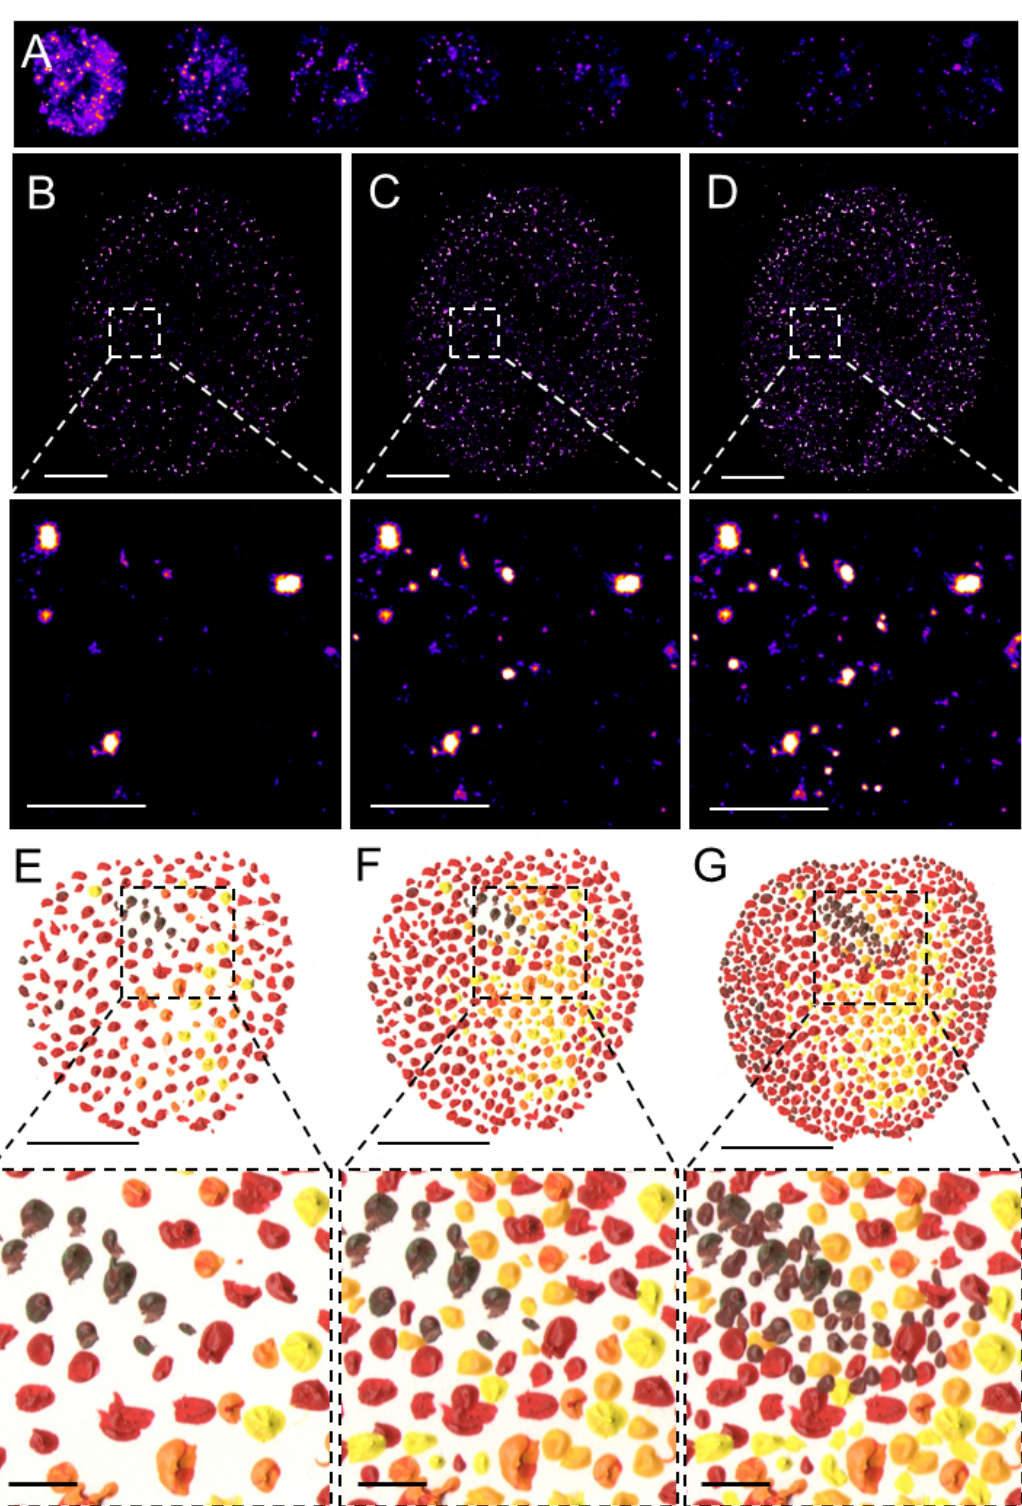
Figure 2. Pointillistic nature of single-molecule localization microscopy. ( A ) Individual frames from the time-lapse acquisition of raw blinking of Alexa Fluor (AF)647-labeled secondary antibody against primary anti-RNAPII antibody (RNAPII-AF647). The signal of individual AF647 molecules accumulates in time ( B , C ) to create the final dSTORM image of RNAPII ( C ). The imaging process in ( B – D ) resembles an artistic painting style called pointillism in which the accumulation of color spots on a canvas ( E , F ) creates the final painting ( G ). Artistic paintings in ( E – G ) were kindly provided by Katarína Mrvová. White bar = 5 µm; inset 1 µm. Black bar = 5 cm; inset 1 cm.